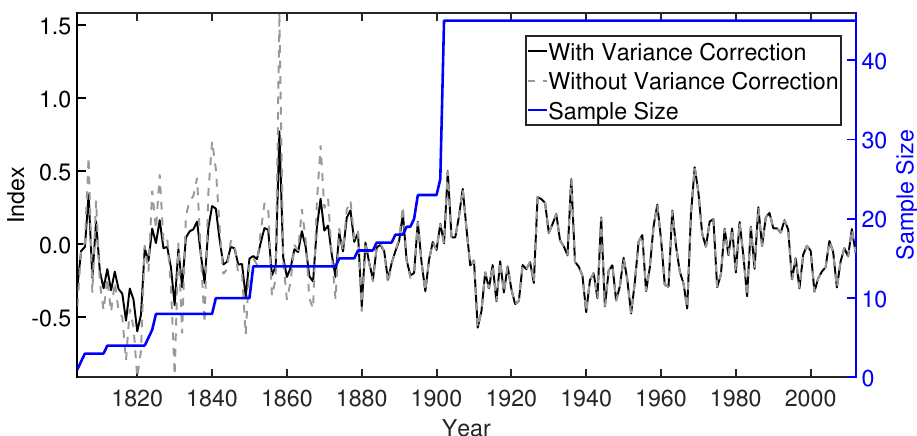
Figure 4. The corrected mean chronology (black line), the change in sample size (blue line), and the mean chronology without variance correction (light gray dashed line).